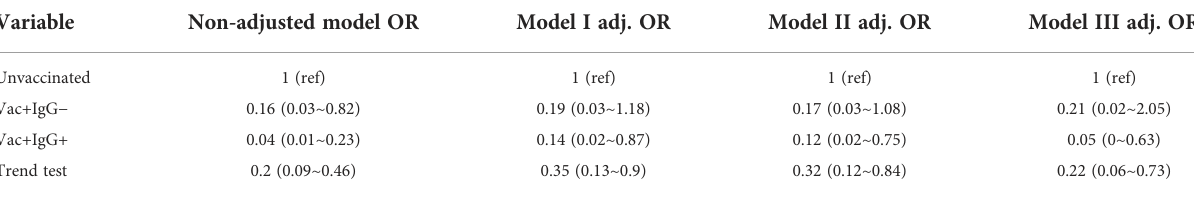
TABLE 3 Multivariate analysis of the incidence of severe cases by vaccination combined with IgG level. Variable Non-adjusted model OR Model I adj. OR Model II adj. OR Model III adj. OR